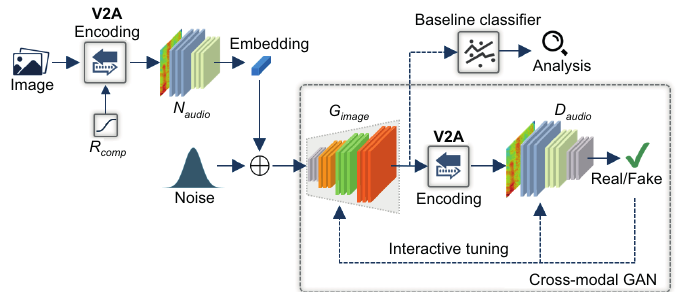
Figure 1. Overall architecture of the proposed computational model to imitate the cross-modal plas- ticity to perceive visual images through audio signal. A cross-modal generative adversarial network (GAN) learns an image-to-audio mapping using an image generator ( G Image ) and audio discriminator ( D Audio ). V2A encoding represents the vOICe, R comp is the compression ratio, and N Audio is the audio